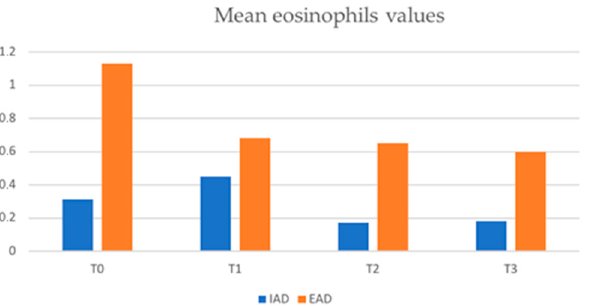
Figure 6. Mean eosinophils values ( × 10 9 /L) in IAD and EAD patients (IAD = intrinsic atopic dermatitis; EAD = extrinsic atopic dermatitis).